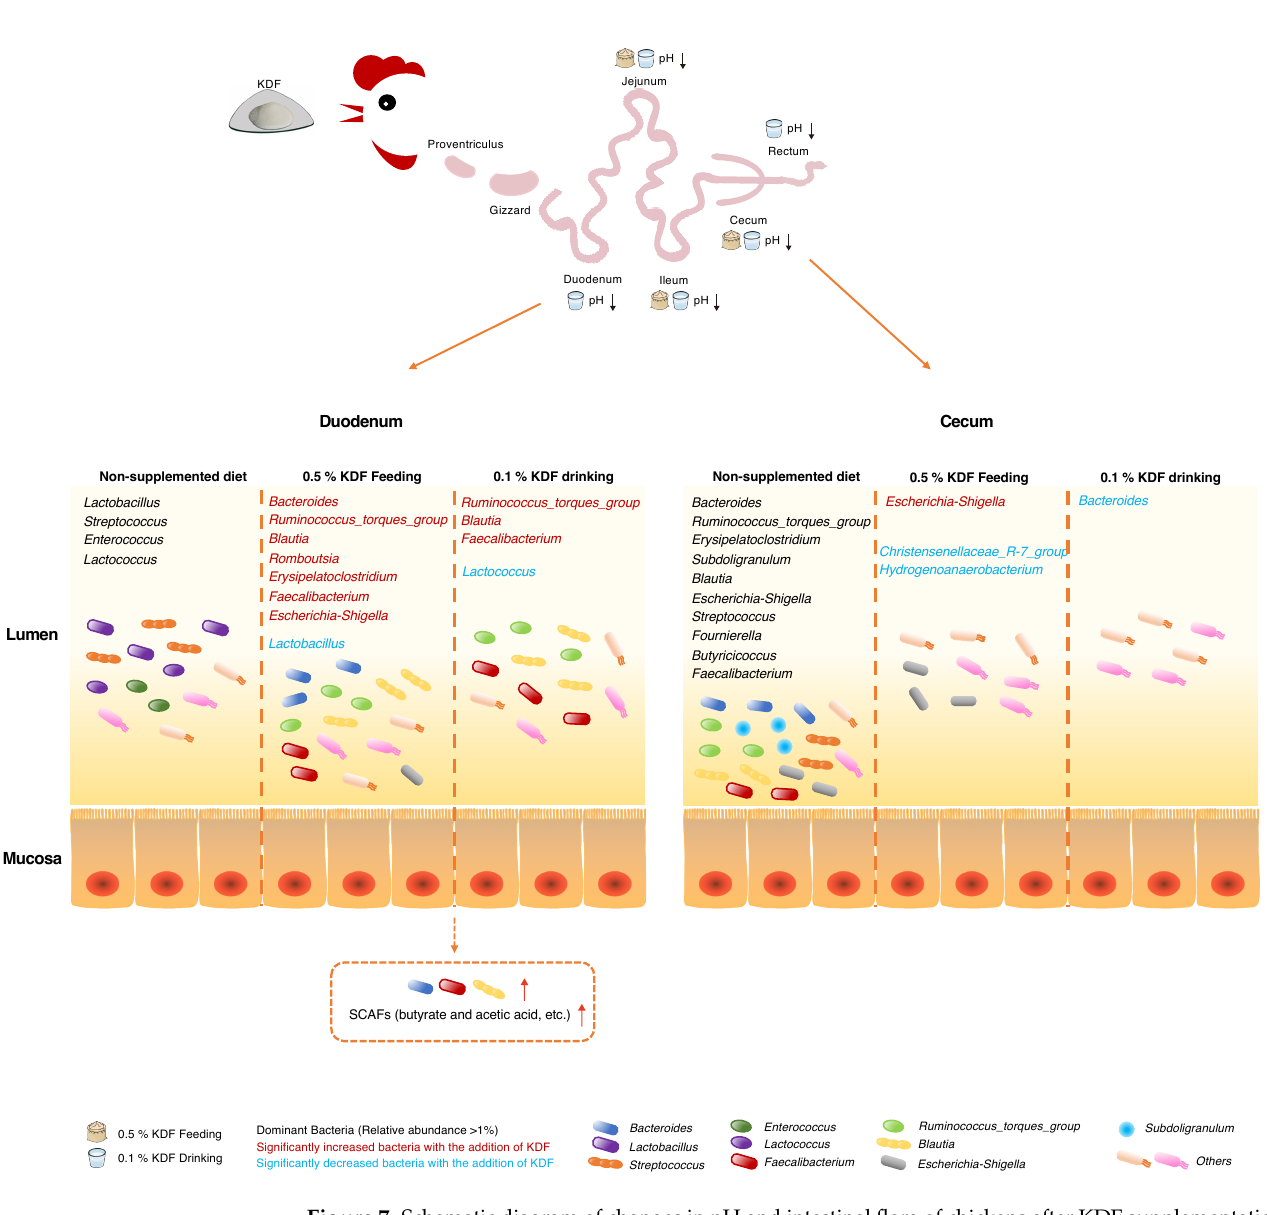
Figure 7. Schematic diagram of changes in pH and intestinal flora of chickens after KDF supplementation. In the present study, the situations observed in the cecum were quite different from those in the duodenum, with changes only in Bacteroides, Christensenellaceae_R-7_group, Hydrogenoanaerobacterium and Escherichia-Shigella. Several studies have revealed that organic acid administered in feed or water are mainly metabolized and absorbed in the up- per gastrointestinal segments of poultry, which is consistent with the pH changes detected after KDF treatment in the present study. Therefore, the minor influence on the microbiota in cecum probably results from the weaker effect of KDF on the distal intestine